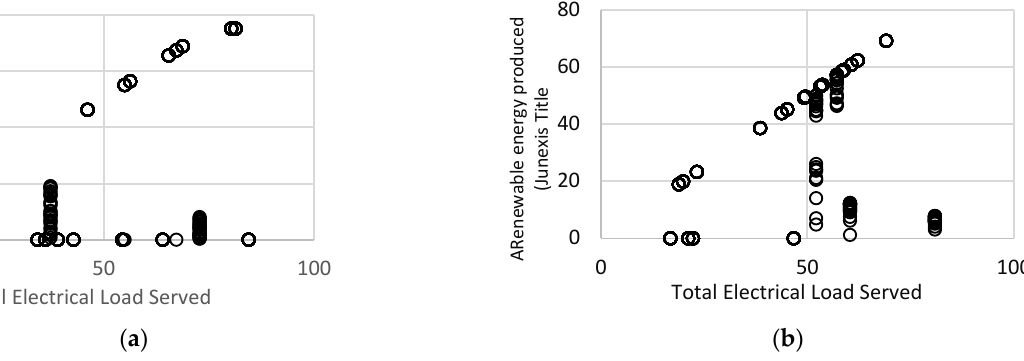
Figure 16. Class index; the potential renewable energy (kW) that served the total energy demand (kW), January ( a ), June ( b ).